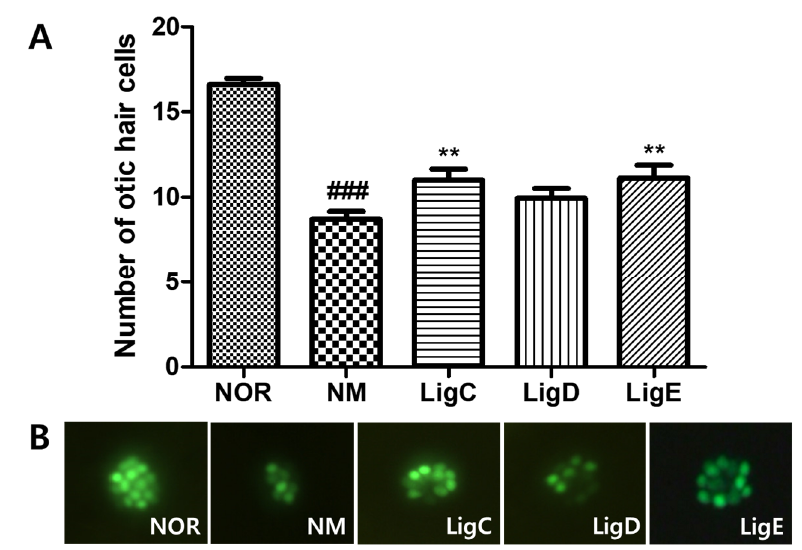
Figure 3. Recovery of otic hair cells after neomycin-induced hair cell damage. ( A ) The numbers of otic hair cells in the untreated group (NOR), the neomycin treatment group (NM), and the phthalide glycoside treatment groups (LigC, LigD, LigE; 0.1 µ M). ( B ) Fluorescence images of the zebrafish otic hair cells. Hair cells were stained with 0.1% YO-PRO-1. Data are presented as means ± SEM. ** p < 0.01 (control versus treated groups). ### p < 0.001 (normal group versus control group). LigC, ligusticoside C (1); LigD, ligusticoside D (2); LigE, ligusticoside E